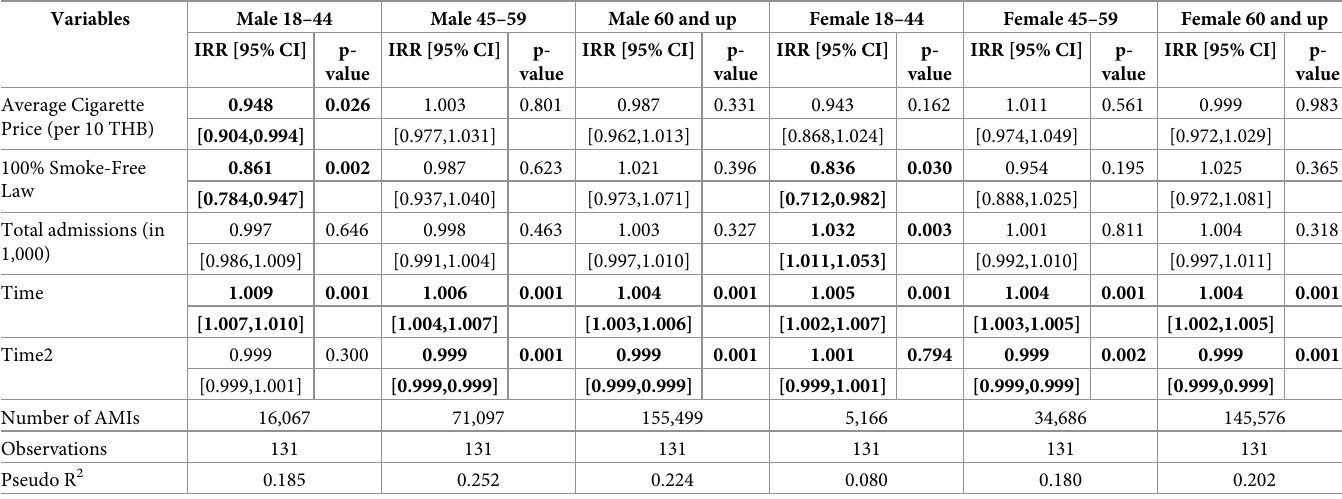
Coefficients for monthly seasonal variables and the lagged variables not